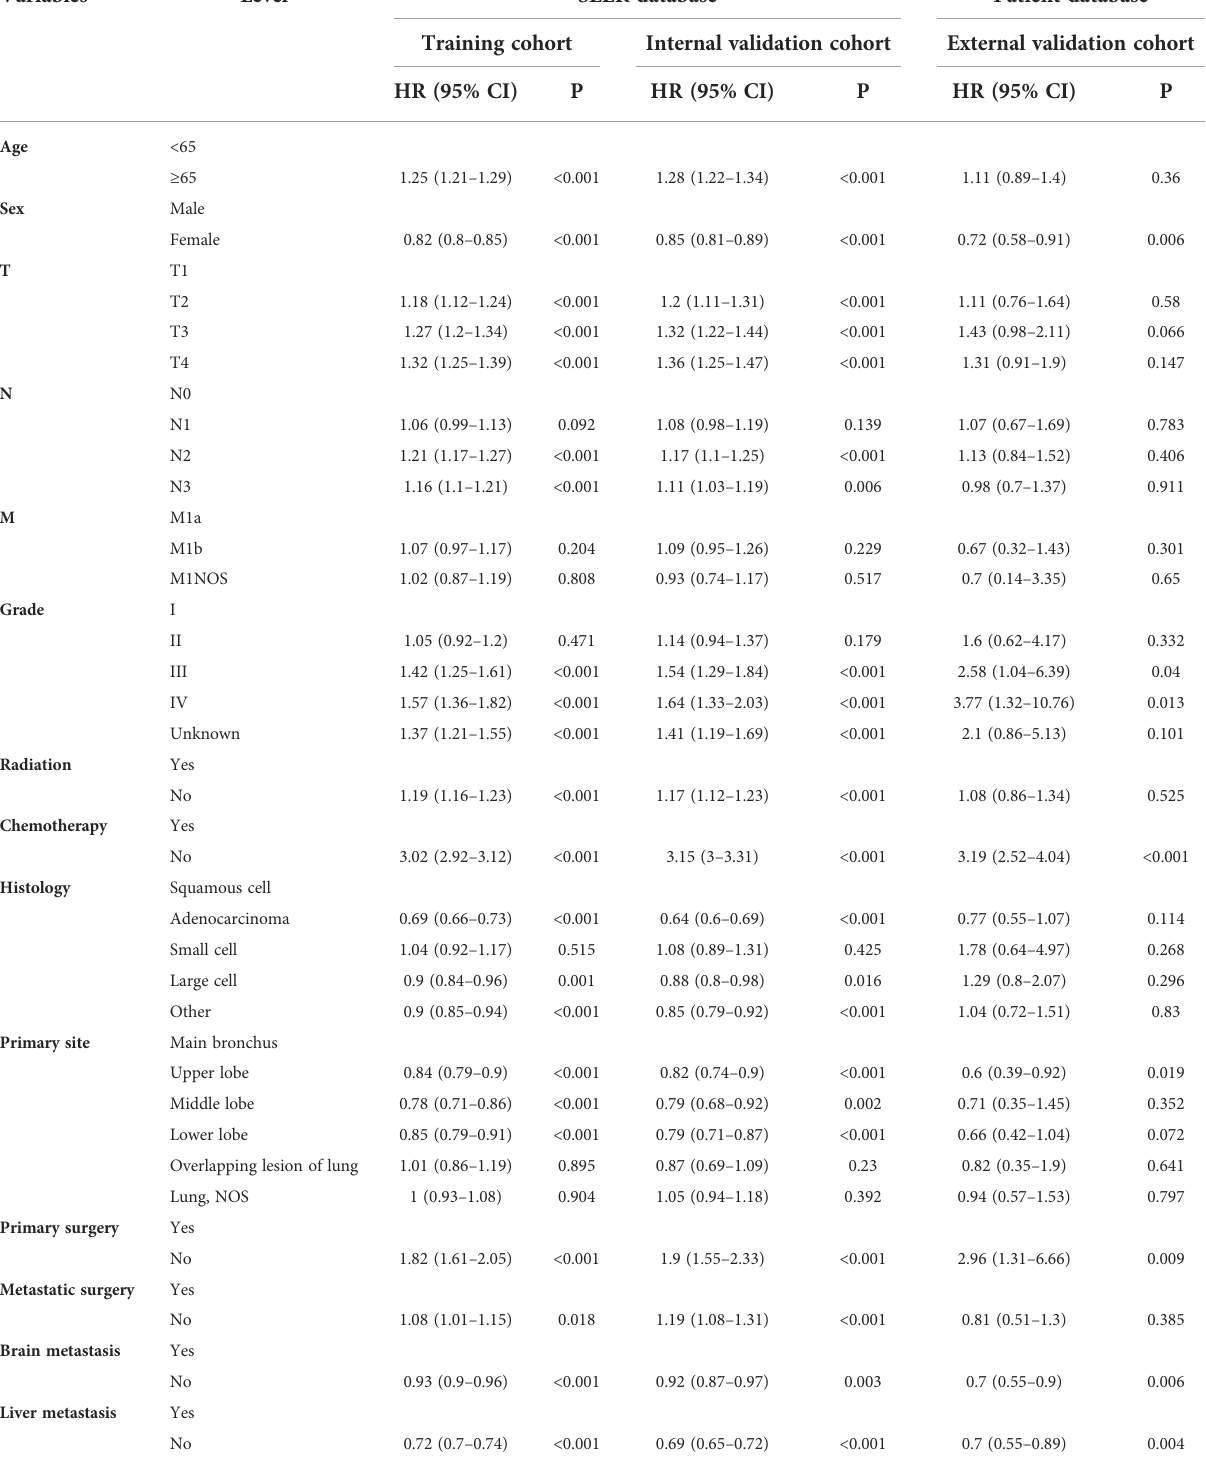
TABLE 4 Univariate Cox regression model in the training, internal validation, and external validation cohorts of cancer-speci fi c survival (CSS) (N,